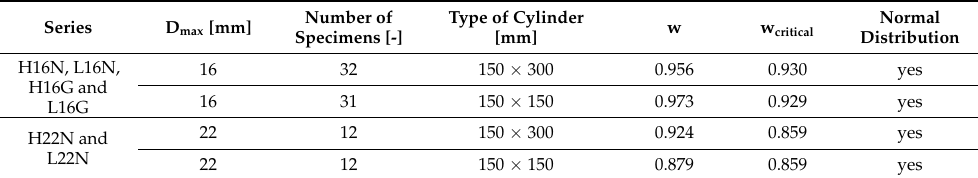
Table 6. The results of Shapiro-Wilk test for chosen groups of series.